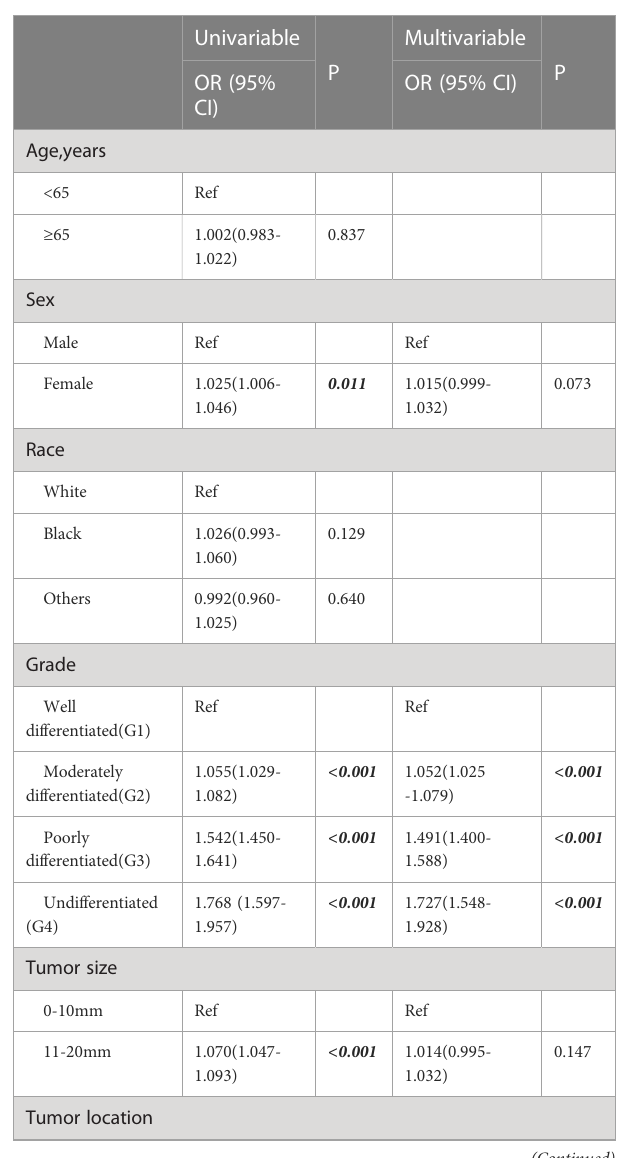
TABLE 4 Logistic regression analysis of clinicopathological factors associated with distant